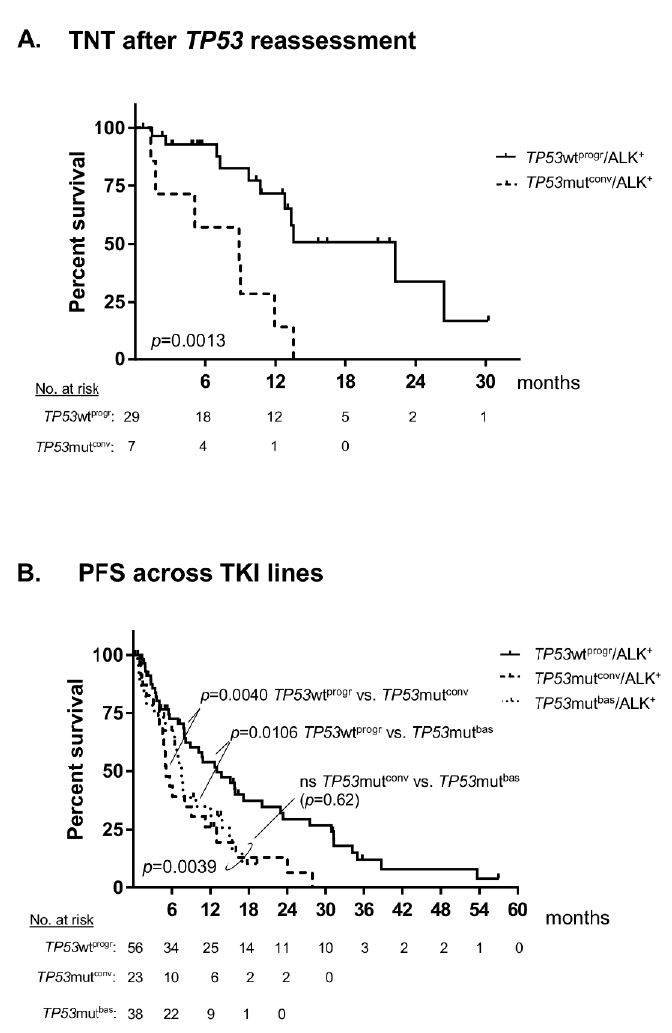
Figure 2. Progression-free survival (PFS) of patients with metastatic anaplastic lymphoma kinase-positive (ALK + ) non-small cell lung cancer (NSCLC) under treatment with tyrosine kinase inhibitors (TKI) according to TP53 status at baseline and progression. ( A ) The median time-to-next-treatment (TNT) under TKI for patients with initially wild-type TP53 tumours after reassessment of TP53 status was 9 months for cases with a positive result ( TP53 mut conv ) vs. 23 months for cases with negative result ( TP53 wt progr , logrank p = 0.0013). Treatment details including continuation of treatment beyond disease progression are given in Table 1. ( B ) The median PFS under TKI treatment across all treatment lines was 8 months for patients with TP53 mutations at baseline ( TP53 mut bas ) vs. 5 months for patients with initially wild-type status and detection of TP53 mutations in a subsequent biopsy ( TP53 mut conv ) vs. 13 months for patients without subsequent detection of TP53 mutations ( TP53 wt progr , logrank p = 0.0039); ns: not significant. Table 1. Patient characteristics and details of treatment.